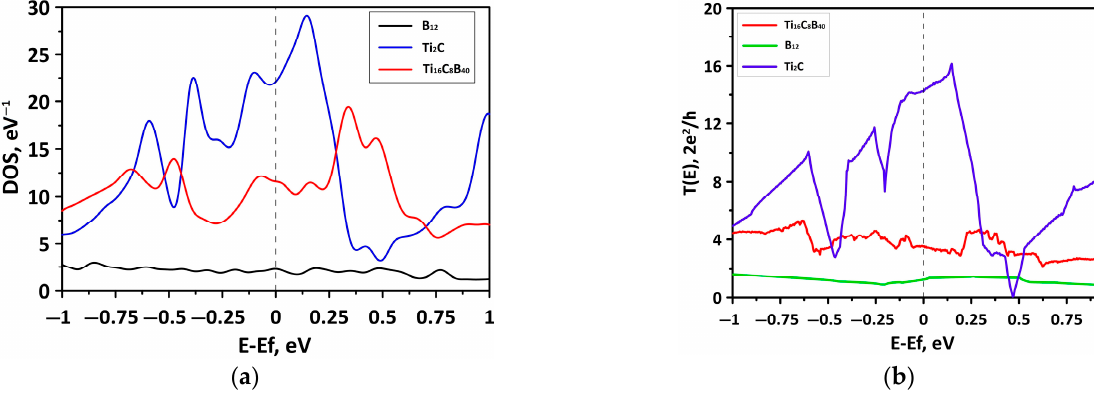
Figure 2. The electronic and energy characteristics of the composite material, Ti 16 C 8 B 40 , and individual layers, Ti 2 C and B 12 : ( a ) DOS; ( b ) electron-transmission function.